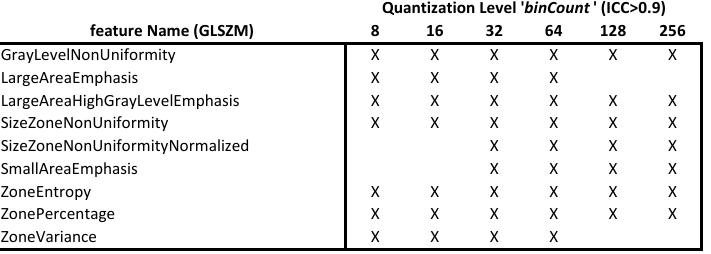
Figure 4. Dependence of the quantization level of GLSZM radiomic features, considering different val- ues (i.e., 8, 16, 32, 64, 128, and 256) of the ‘binCount’ PyRadiomics parameter. The features GrayLevel- NonUniformityNormalized , GrayLevelVariance , HighGrayLevelZoneEmphasis , LargeAreaLowGrayLevelEm- phasis , LowGrayLevelZoneEmphasis , SmallAreaHighGrayLevelEmphasis , and SmallAreaLowGrayLevelEm- phasis were discarded, as the ICC did not overcome the cutoff for any ‘binCount’ setting.